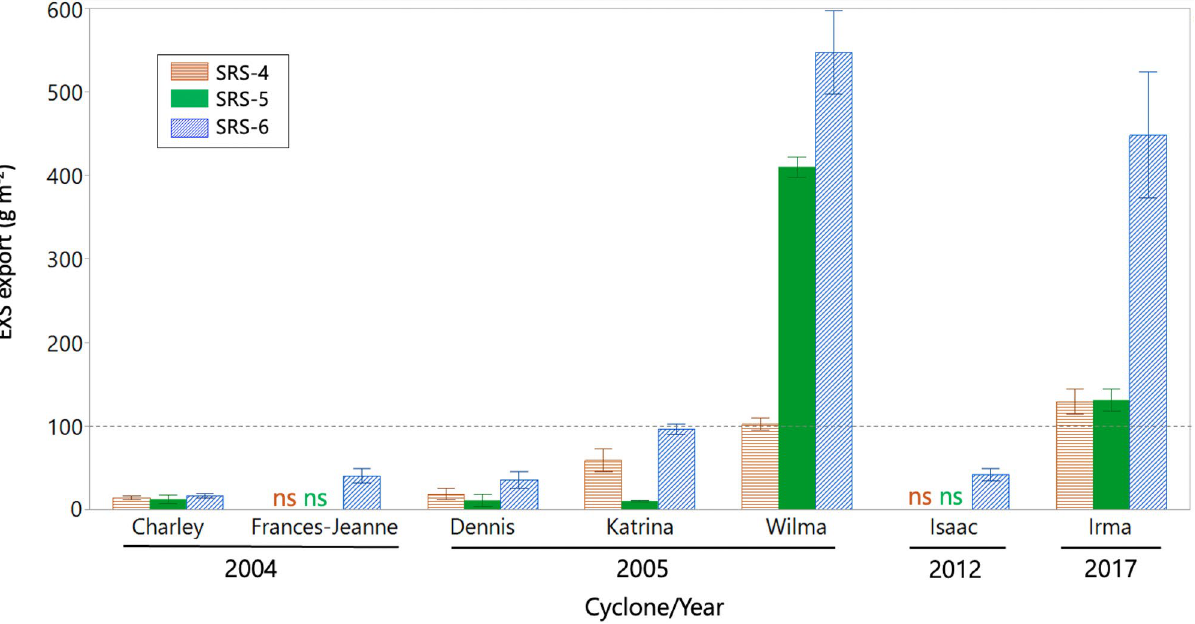
Figure 5. Mean (± SE) storm surge-induced EXS export values (excess litterfall) in three mangrove study sites (SRS-4, SRS-5, SRS-6) along the Shark River Estuary in the Everglades, Florida USA (see “Methods” for details in calculation and analysis). Notice the “ns” indicating no significant EXS values in SRS-4 and SRS-5 in the case of cyclones Frances-Jeanne (2004) and Isaac (2012). Dashed line indicates 100 g m −2 .